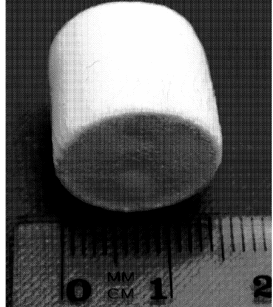
Figure 4. Representative image of the polyurethane/hydroxyapatite